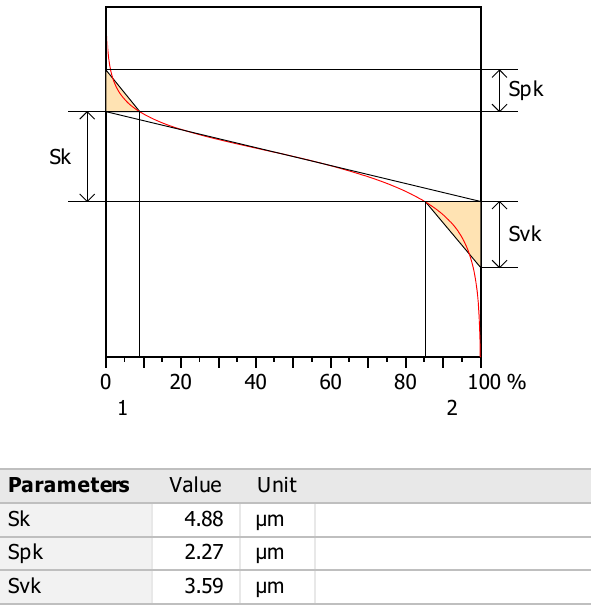
Figure 2. Graphical interpretation of the Spk, Svk, and Sk parameters.